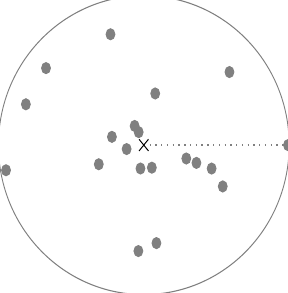
Figure 2. A visual representation of the centroid and the radius in two-dimensions. The centroid is the gravitational center of all data points of the same class, marked by a cross. The radius is given by selecting the maximal distance from the centroid to the data points, represented by a